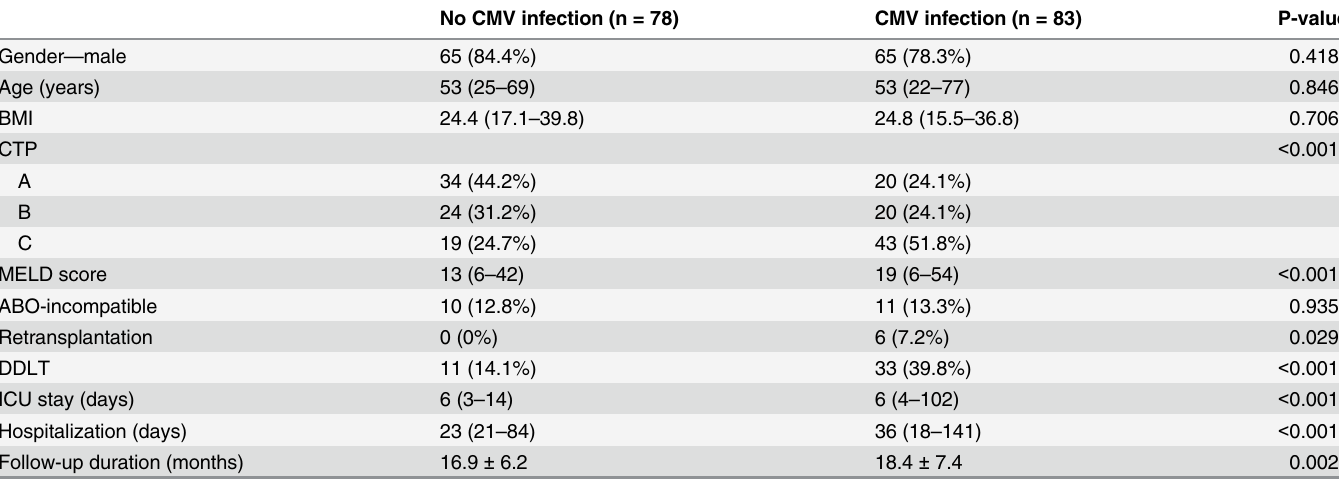
Table 1. Baseline characteristics of patients with and without CMV